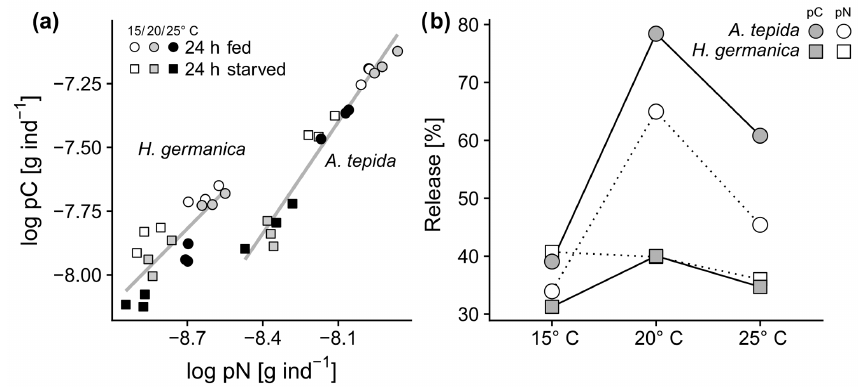
Figure 3. (a) Relationship of pC and pN in A. tepida and H. germanica ( A. tepida : R 2 = 0 . 96, y = 1 . 5 x + 4 . 4, p < 0 . 01; H. germanica : R 2 = 0 . 64, y = x + 0 . 88, p = 0 . 011), and (b) phytodetrital carbon and nitrogen turnover as percent release (of total intake of pC or pN per day,